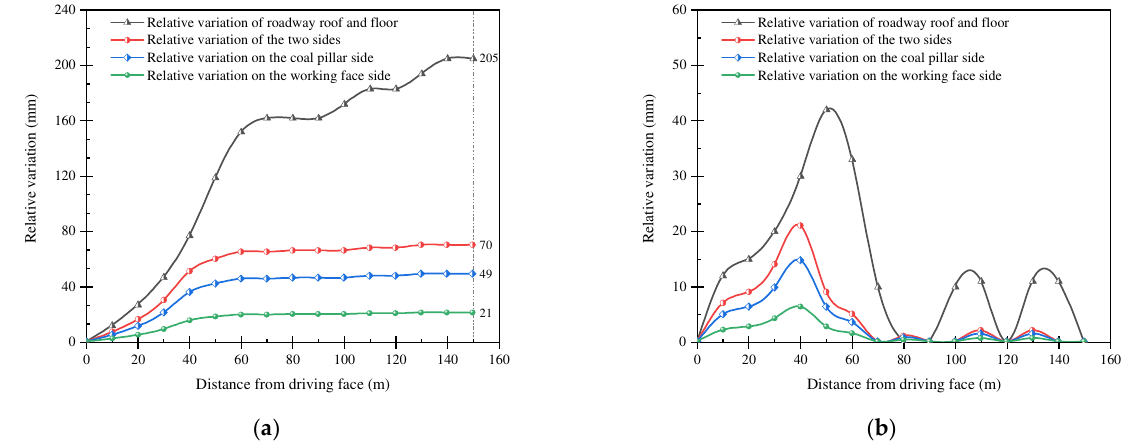
Figure 18. Spatial and temporal evolution characteristics of the deformation and damage of the surrounding rock at station I; ( a ) the displacement of the roadway surface; ( b ) the deformation speed of the roadway surface.